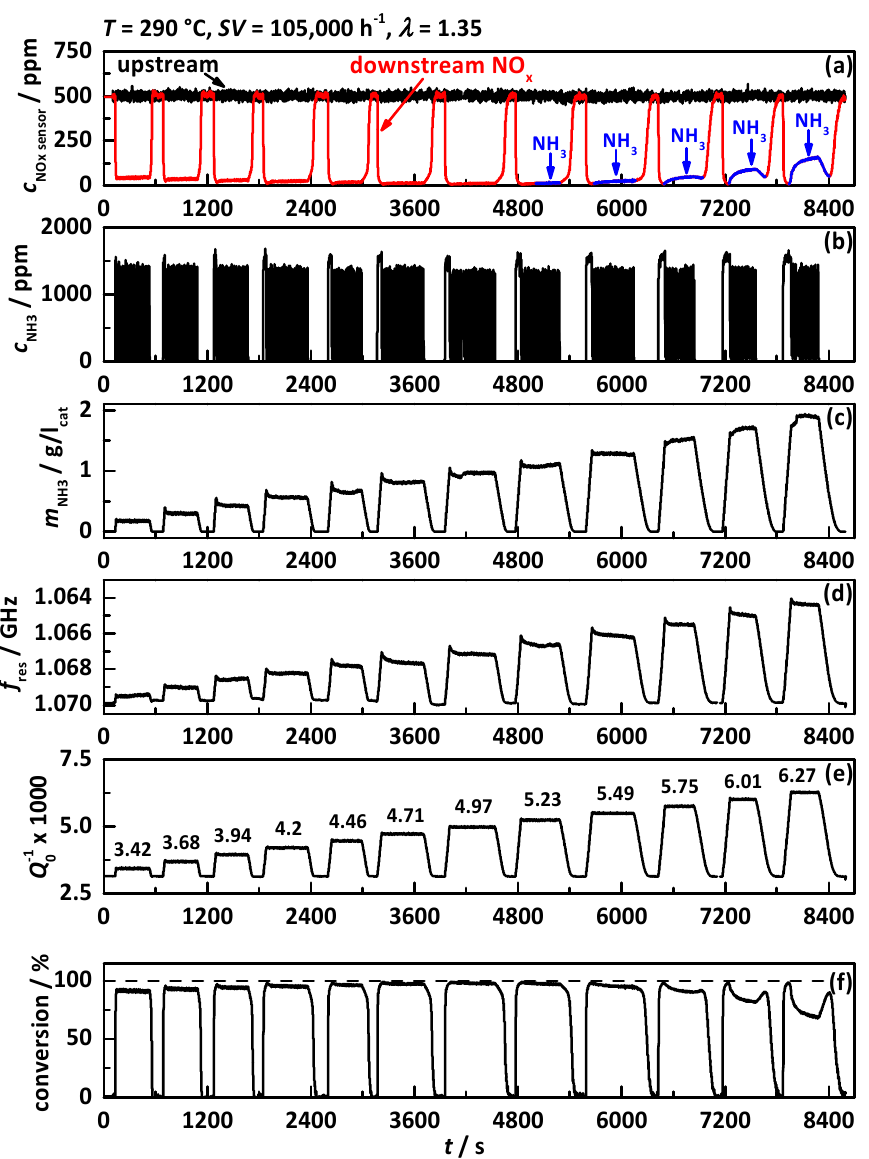
Figure 5. Experiment to investigate the NH 3 storage influence to catalyst performance at 290 °C with SV = 105,000 h − 1 and λ = 1.35: ( a ) NOx sensor signal upstream of DEF dosing (black) and downstream of SCR catalyst (red: assigned to downstream NO x , blue: assigned to downstream NH 3 ); ( b ) dosed NH 3 concentration determined by NO x sensor signals up- and downstream of DEF dosing; ( c ) calculated amount of NH 3 stored on the catalyst; ( d ) resonance frequency f res in reverse scale; ( e ) the reciprocal unloaded quality factor Q 0 − 1 and ( f ) the apparent NO x conversion based on the sensor signals of ( a ).